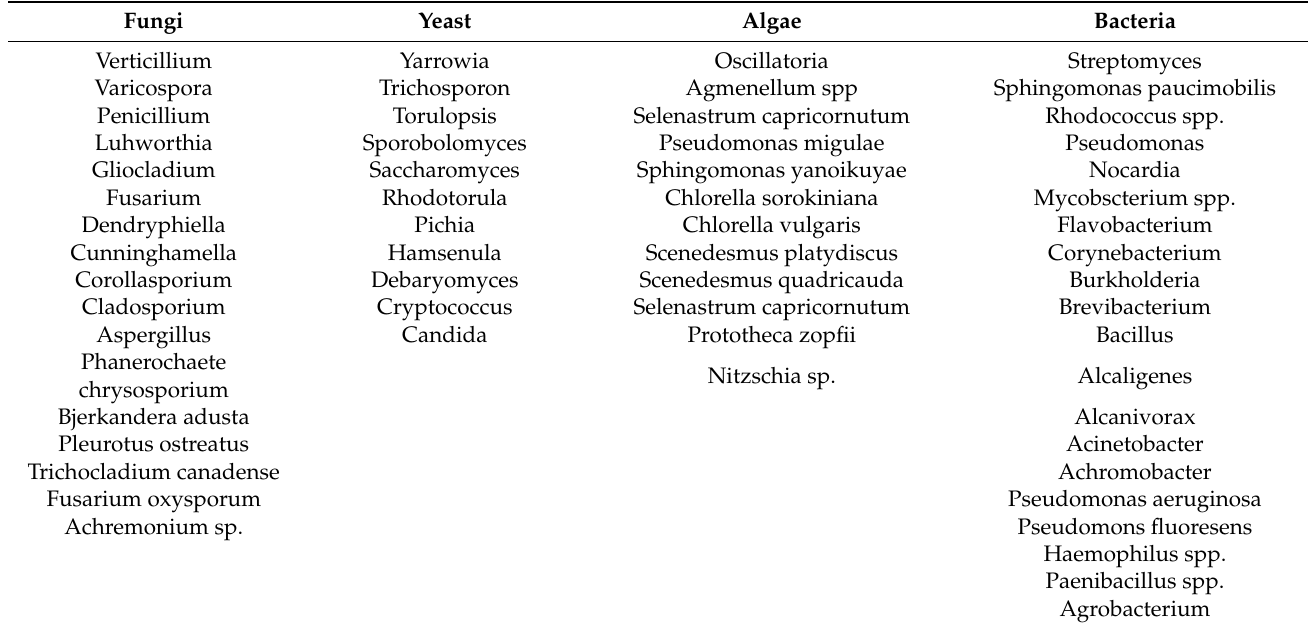
Table 2. Microorganisms are used in the biodegradation of petroleum